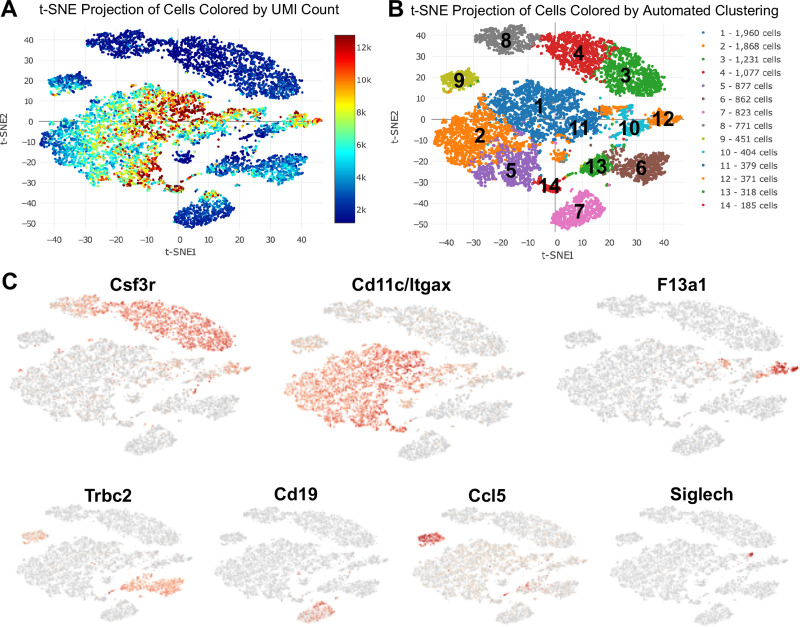
Unsupervised single-cell transcriptional profiling of lung CD45+ cells identifies 14 unique clusters among Sham, CIA, ODE, and CIA+ODE treatment groups.Lung immune cells were isolated from mice (N = 2 mice/group) treated with Sham, CIA, ODE and CIA+ODE. (A) T-distributed stochastic neighbor embedding (t-SNE) plot shows projection of unique molecular identifier (UMI) count among cell clusters. (B) Distribution of cells by unsupervised clustering in t-SNE showing lung immune cell populations. (C) Major lung cell types identified by signature genes including Csf3r (neutrophils), Cd11c/Itgax (macrophages), F13a1 (monocytes), Trbc2 (T lymphocytes), Cd19 (B lymphocytes), Ccl5 (NK cells), and Siglech (dendritic cells).